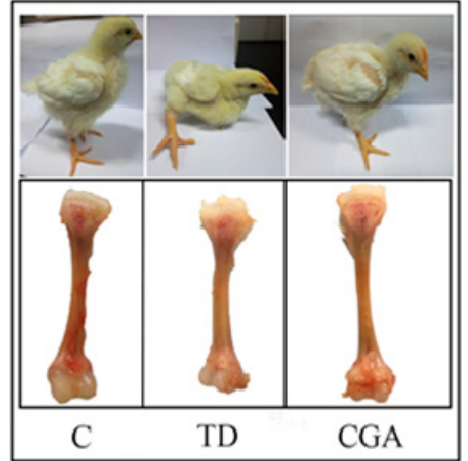
Figure 1. Overall clinical observation during the animal experiment. Control group represents chickens with normal diet, TD group represents chickens with normal diet plus 50 mg/kg thiram, CGA group represents the administration of chlorogenic acid after the induction of TD.